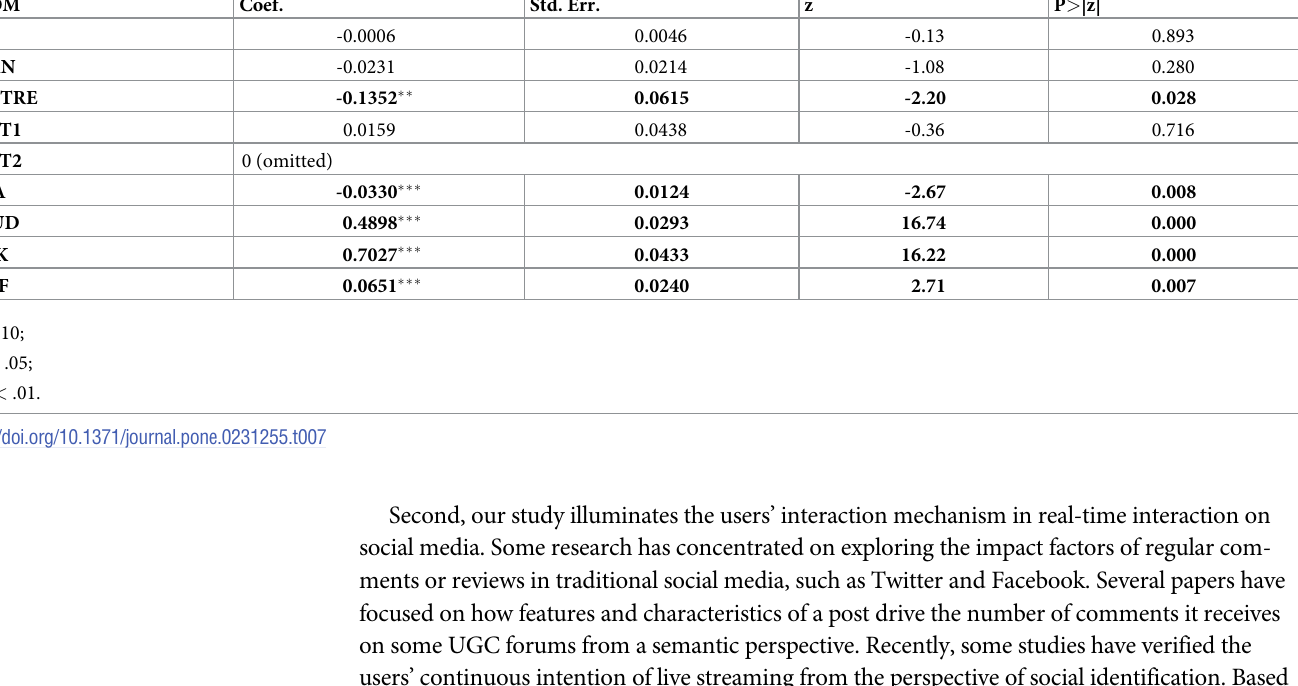
Table 7. Parameter estimates for the Negative Binomial model for talent shows ( N = 610). RECOM Coef.